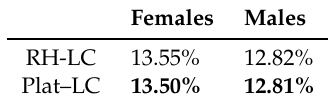
Table 8. MAPE of the models for Maltese population.